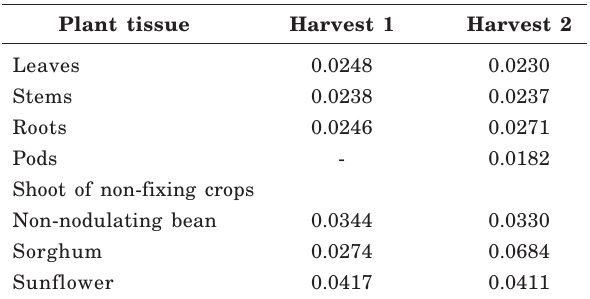
Table 1. Enrichment of 15 N (in atom% 15 N excess) of different plant tissues of common bean and of shoots of non-fixing crops in experiment 2; means of four replicates for non-fixing crops and eight replicates for inoculated bean plants originating from seeds with low or high Mo